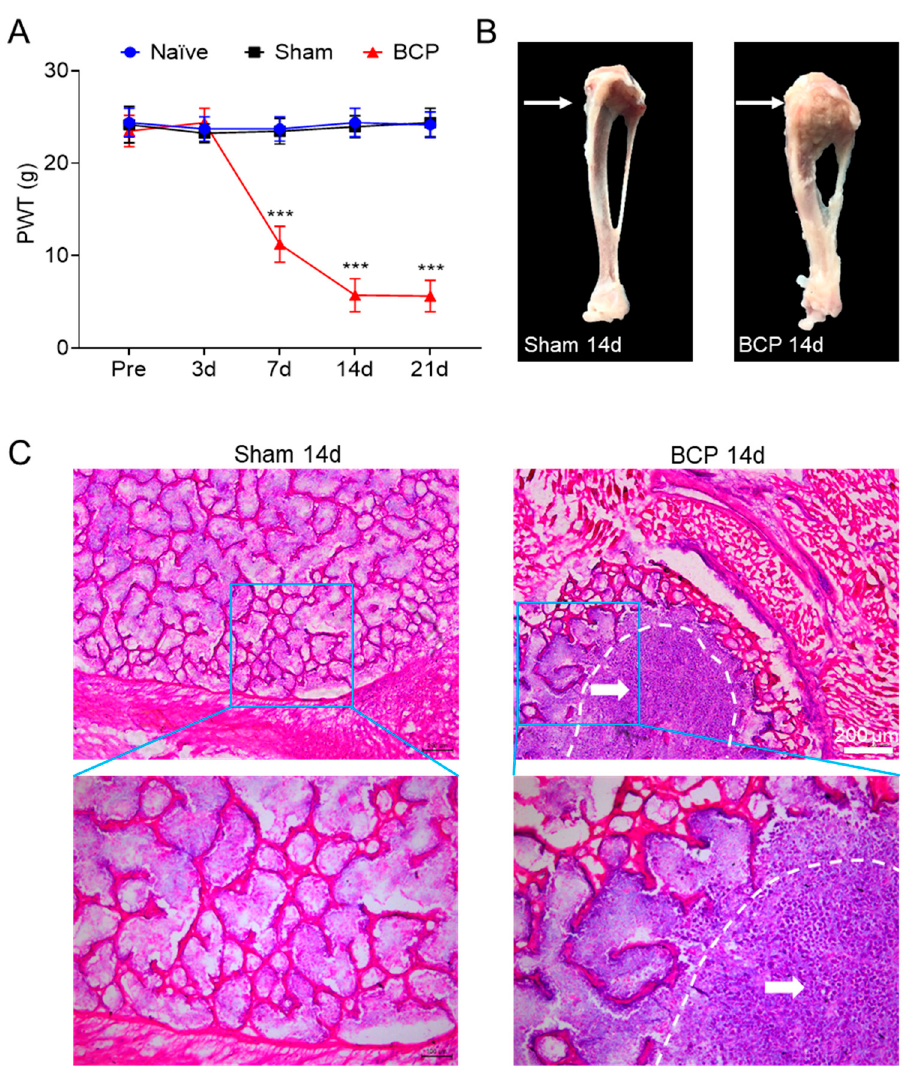
Figure 1. The bone cancer pain model was successfully established by injecting Walker 256 tumor cells into the tibia of rats. ( A ) The mechanical pain threshold was significantly reduced from day 7 to day 21 in rats after surgery compared with the naïve group and sham group (*** p < 0.001 vs. sham group, n = 8, two-way ANOVA followed by Tukey’s multiple comparisons test). Pre, preoper- ative. ( B ) We compared the tibia of the operated side in the BCP group and the sham group. The arrow points demonstrated that tumor expansion had destroyed the bone in the BCP rat. ( C ) The tibial bone in the sham rats was intact, and the arrangement of the trabecular bone structure was orderly, as demonstrated by HE staining. Red blood cells, lymphocytes, and macrophages are pre- sent in large numbers in the bone marrow cavity. However, the morphological changes of trabecular bone were lost, and the bone cortex was thinned and even destroyed in the BCP rats, who also had a large number of tumor cells filling the bone marrow cavity at the posterior end of the rat tibia. The region circled by the white dashed line represents the invasion of cancer cells. 3.2. The Expression of TET1 and TRPV4 Was Increased in L4–6 DRG of BCP Rats To investigate the expression of TET1 and TRPV4 in L4–6 DRG of BCP rats, we per- formed qPCR and Western blotting at days 0, 3, 7, 14, and 21 after tumor cell inoculation. According to qPCR results, TET1 and TRPV4 mRNA levels gradually increased after the onset of bone cancer pain compared to those in the sham group (Figure 2A,C), but TET2 mRNA levels remained constant over time (Figure 2B). Western blotting showed that the TET1 expression increased from day 3 and persisted for 21 days after tumor cell inocula-